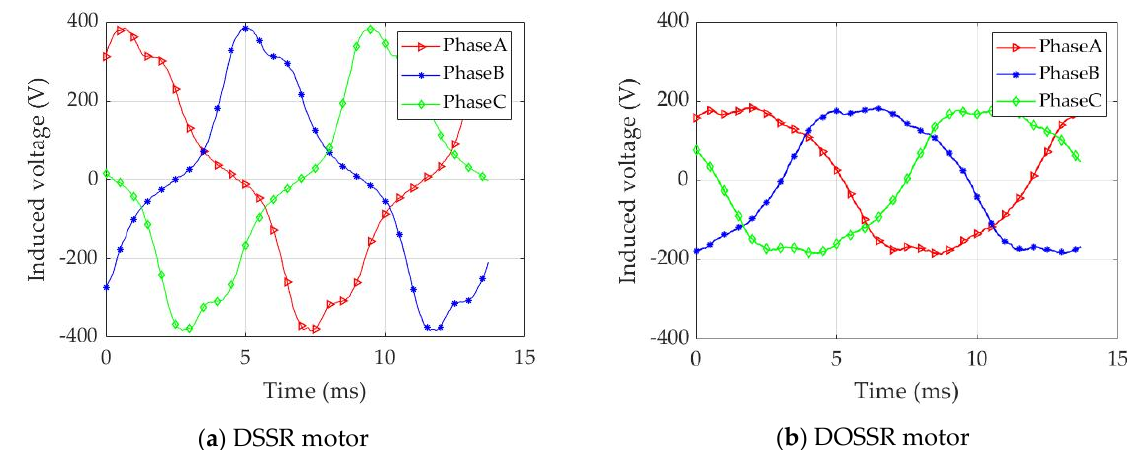
Figure 9. Induced voltage for the DSSR motor and the DOSSR motor (100 A rms, 900 rpm).